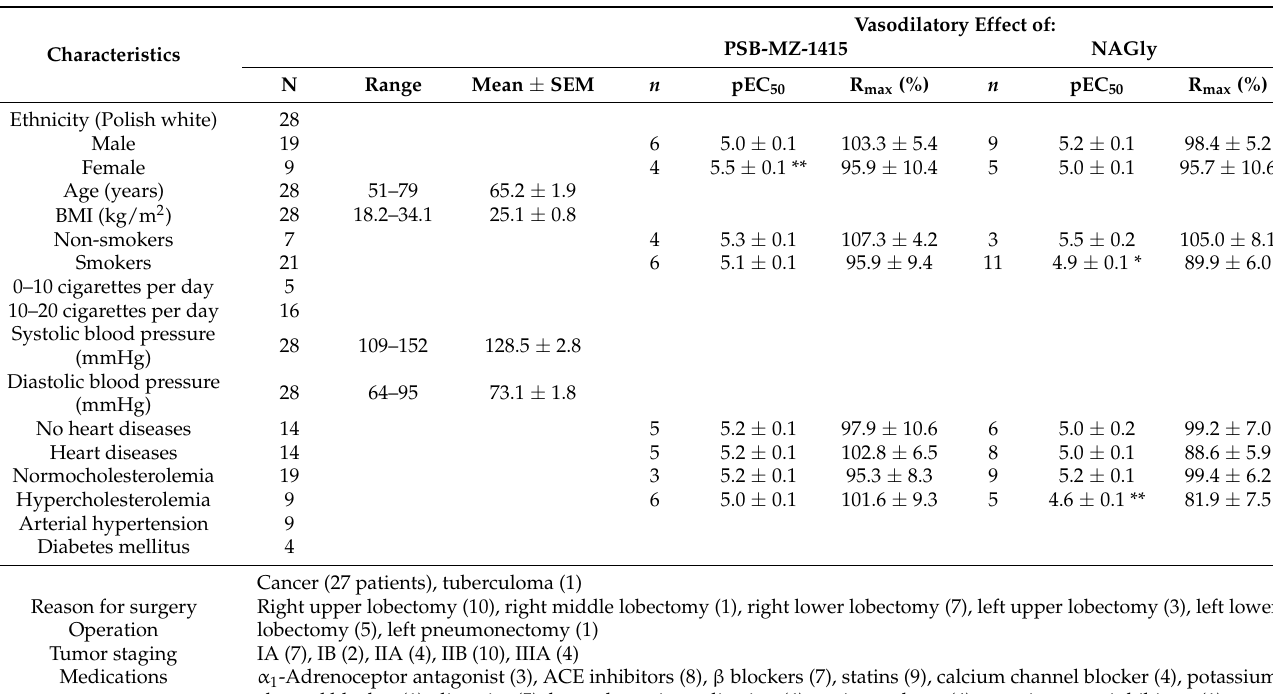
Table 3. Patient characteristics, diagnosis, types of operations, medications and post hoc analysis of the effect of sex and co-morbidities on PSB-MZ-1415- and NAGly-mediated vasorelaxation in isolated human pulmonary arteries.